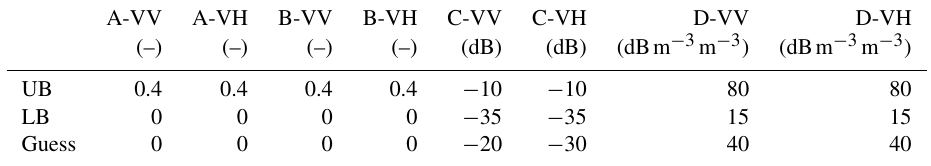
Table 1. Lower boundaries (LB), upper boundaries (UB), and prior guess values of the WCM parameters for both VV and VH